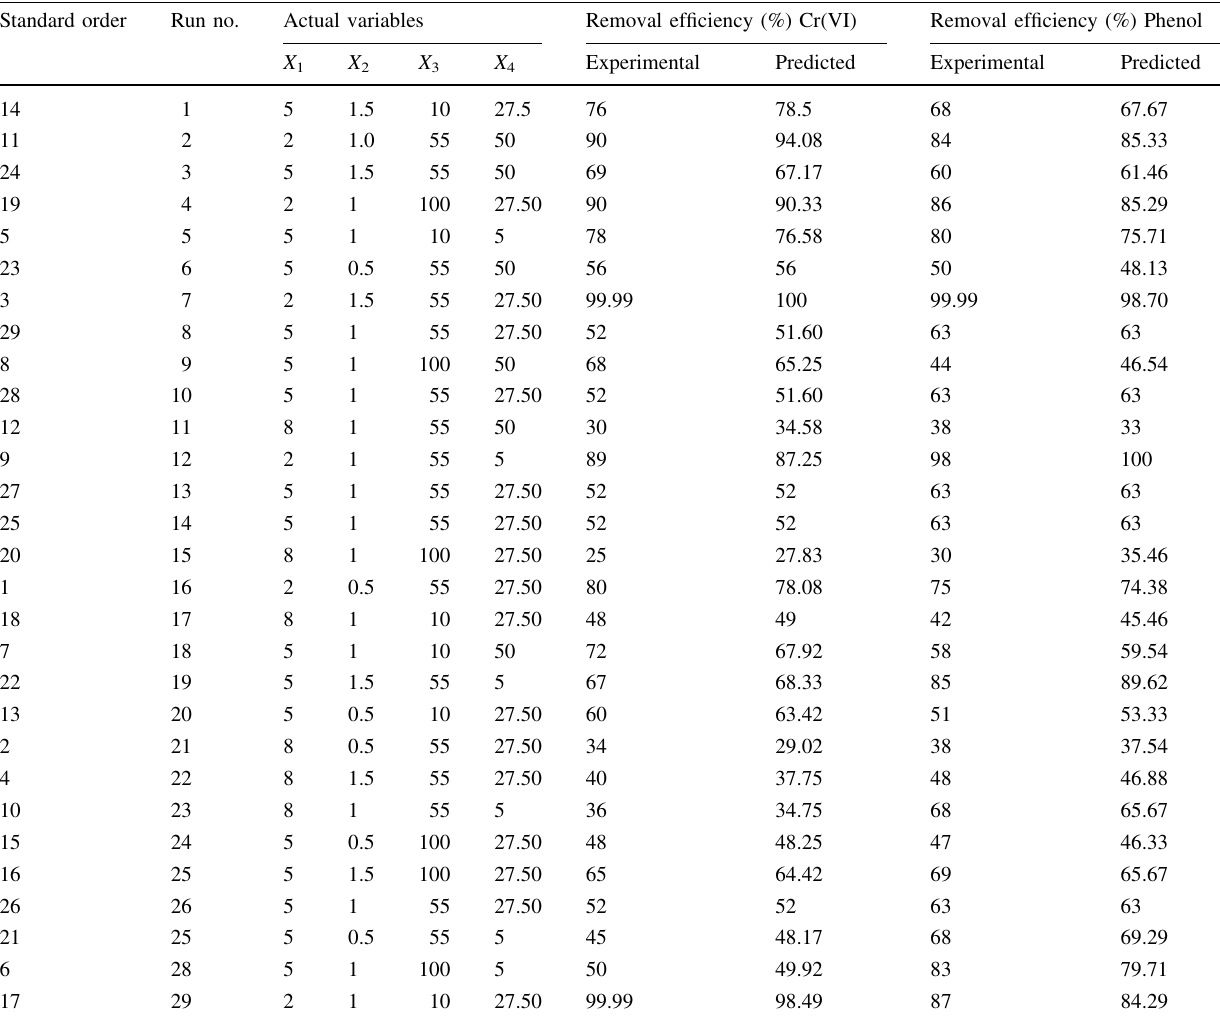
Table 6 Experimental design matrix developed by Box–Behnken design for removal of chromium Standard order Run